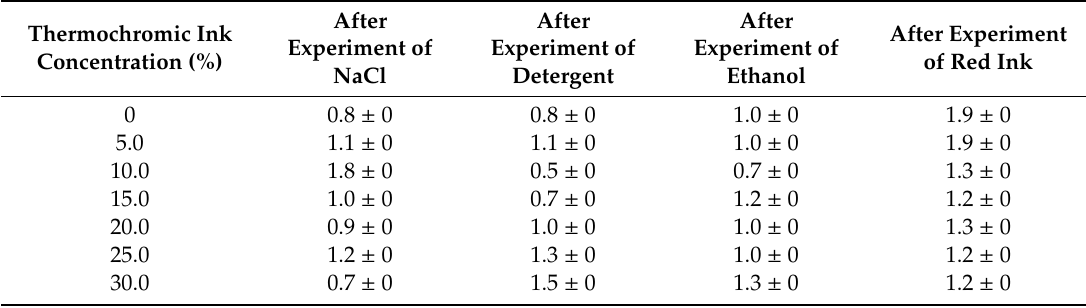
Table 4. E ff ect of thermochromic ink concentration on colour diference of waterborne finish film for liquid